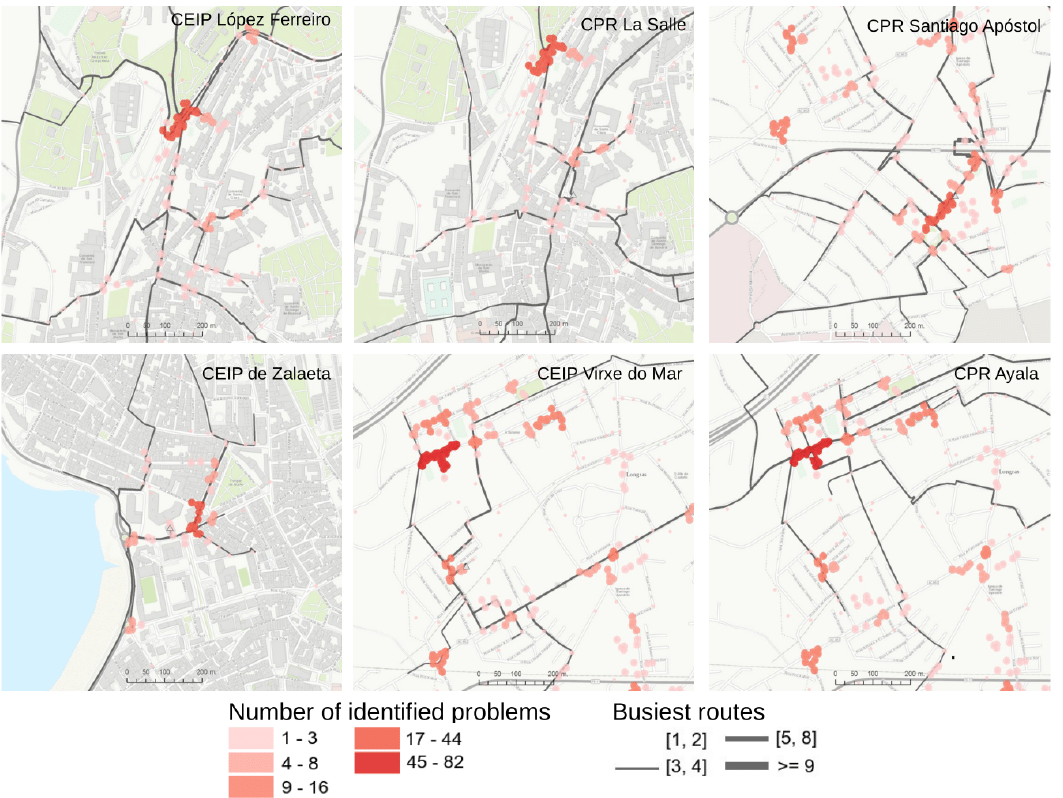
Figure 13. Graphical representation of the problems identified by students on their daily home–school routes. Identification of problems given by number and optimal routes classified by number of